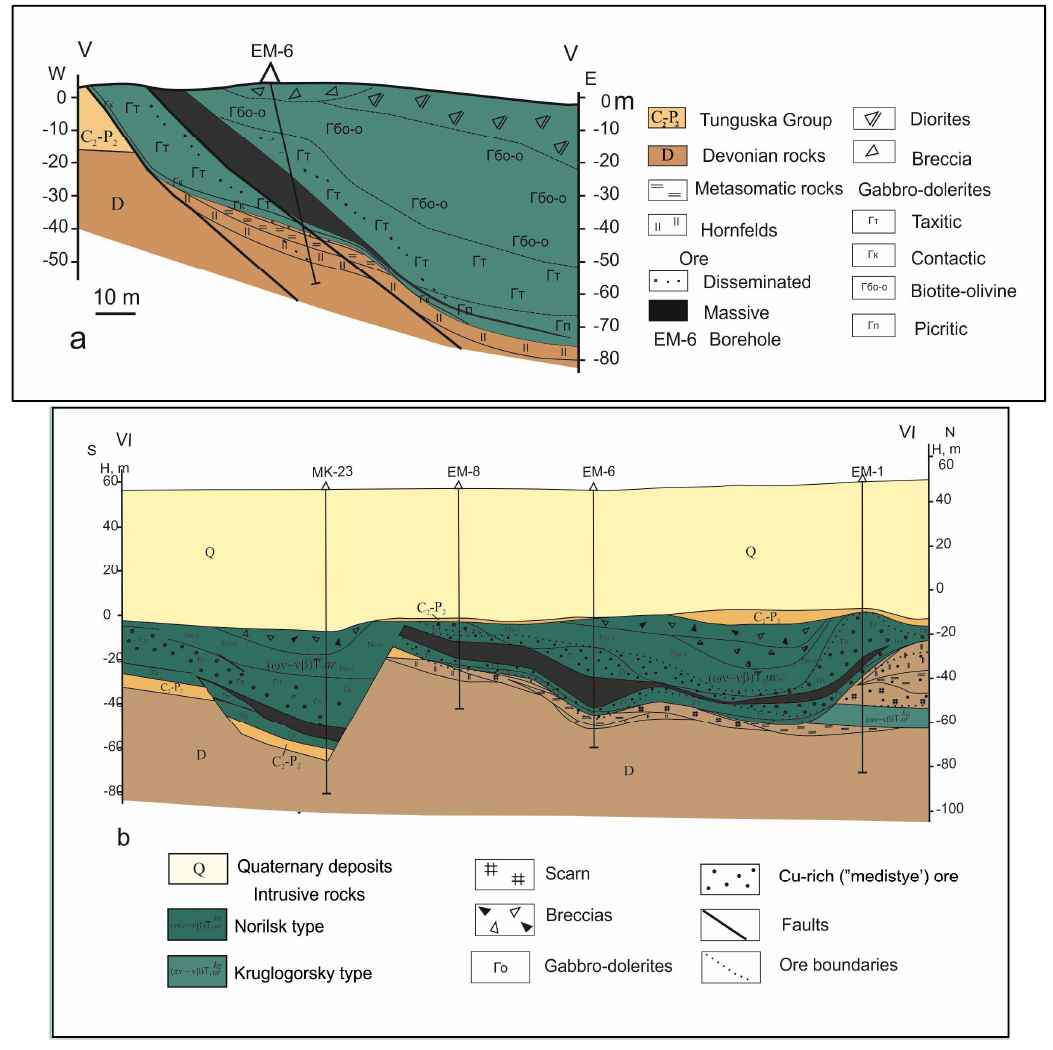
Figure 7. Position of the Southern 2 orebody inside the South-Westbranch, the cross-sections V-V ( a ) and VI-VI ( b ) (after Ltd. Norilskgeologia data with author’s corrections).